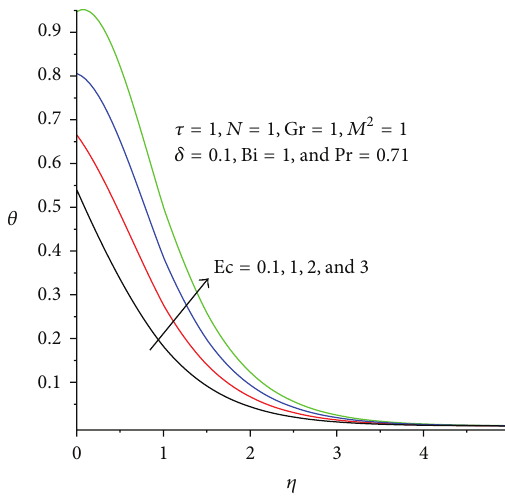
Figure 12: Temperature profiles with increasing Gr.